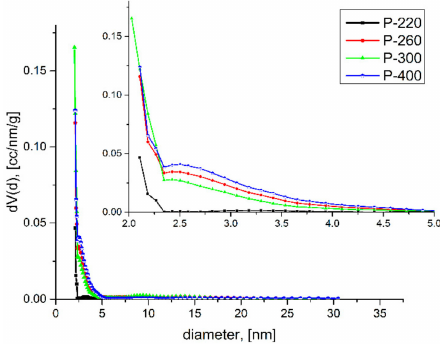
Figure 3. Pore size distribution evolution with firing